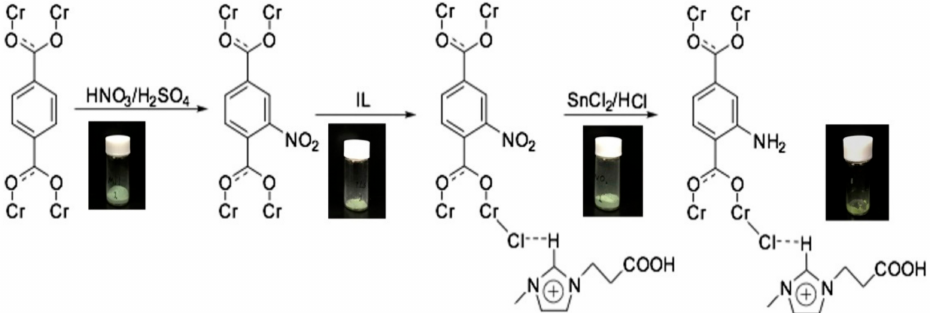
Figure 20. Preparation stages for the synthesis of IL/MIL-101-NH 2 . Reprinted with permission from Ref. [158]. Copyright 2018 Elsevier.